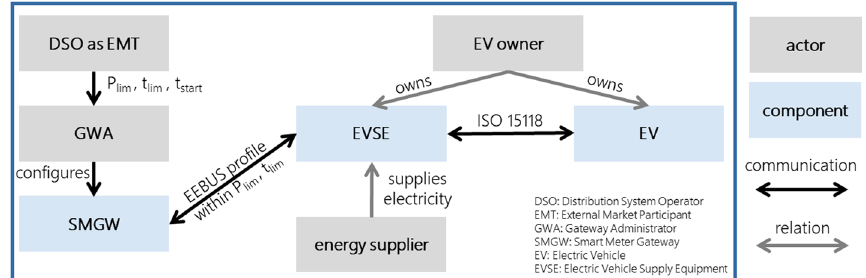
Fig. 3 Technical use case description for the load management through